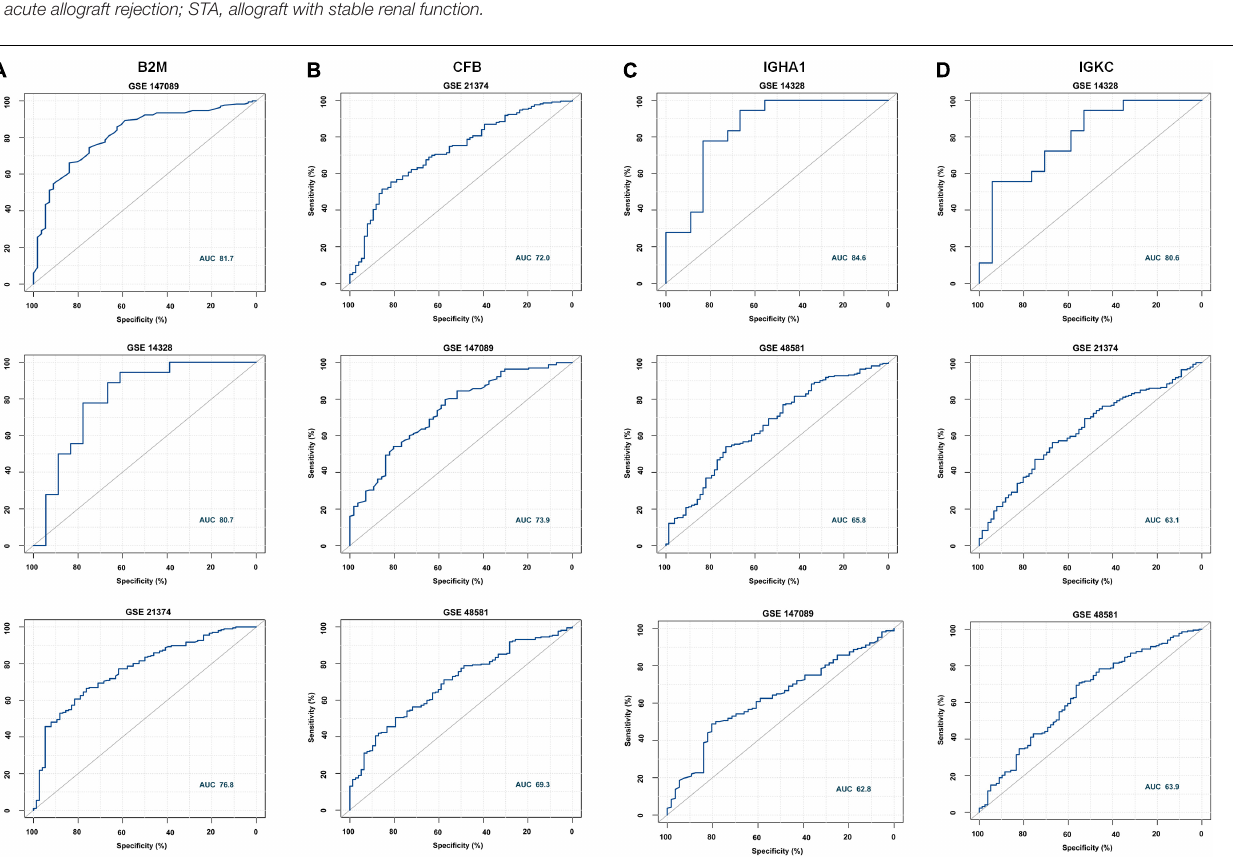
FIGURE 3 | Receiver operating characteristic (ROC) curve of B2M, CFB, IGHA1, and IGKC in different GEO data sets. (A) ROC of B2M in GSE147089, GSE14328, and GSE21374 with AUC values of 81.7, 80.7, and 76.8, respectively. (B) ROC of CFB in GSE21374, GSE147089, and GSE48581 with AUC values of 72, 73.9, and 69.3, respectively. (C) ROC of IGHA1 in GSE14328 and GSE147089 with AUC values of 84.5, 65.8, and 62.8, respectively. (D) ROC of IGKC in GSE14328, GSE21374, and GSE48581 with AUC values of 80.6, 63.1, and 63.9,